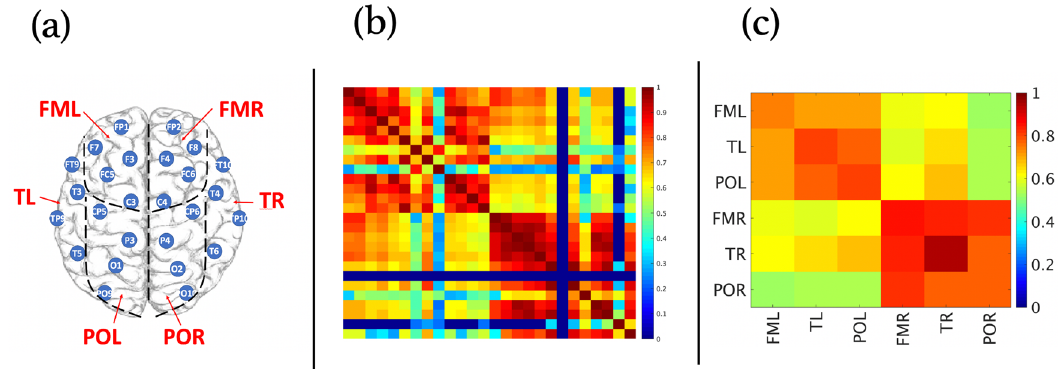
Fig. 1 Construction of brain wave synchronization matrices based on EEG electrode position. a Data were recorded by a 32-channel EEG montage according to the international 10 − 20 standard system (the four midline electrodes Fz, Cz, Pz, Oz, and the two reference electrodes M1 and M2 were excluded from the analysis). Electrodes were grouped according to different brain lobes (as indicated by the dashed lines): frontal motor left — FML (including electrodes FP1, F7, F3, FC5, and C3); frontal motor right — FMR (FP2, F8, F4, FC6, and C4); temporal left — TL (FT9, T3, TP9, and T5); temporal right — TR (FT10, T4, TP10, and T6); parietal occipital left — POL (CP5, P3, O1, and PO9); and parietal occipital right — POR (CP6, P4, O2, and PO10). b Matrix of the averaged synchronization indexes h R j 1 ; j 2 i ν for all combinations of α -amplitude signals j 1 and j 2 from all 26 electrodes of a single PD + FoG + subject. Averaging was done over all normal walking segments ν . Note that we exclude electrodes with high impedance or high standard deviations from our analysis (e.g., the two dark blue lines in panel ( b ) corresponding to electrode CP6). c The matrix elements of panel ( b ) are averaged according to the de fi nition of brain lobes shown in ( a ) to obtain a brain wave synchronization matrix. Matrix elements that correspond to the same electrode interaction (i.e., the diagonal elements in ( b )) have been excluded from the